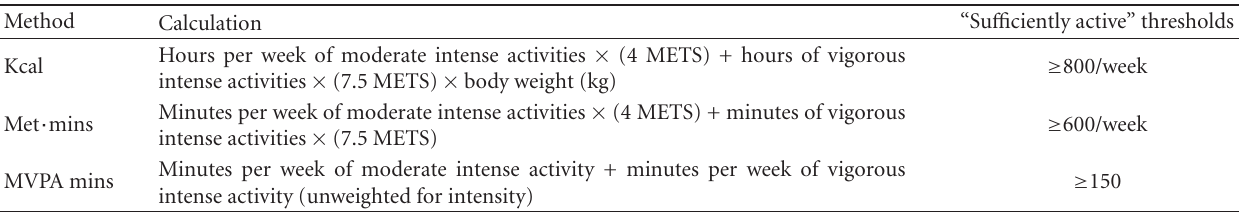
Table 1: Methods of